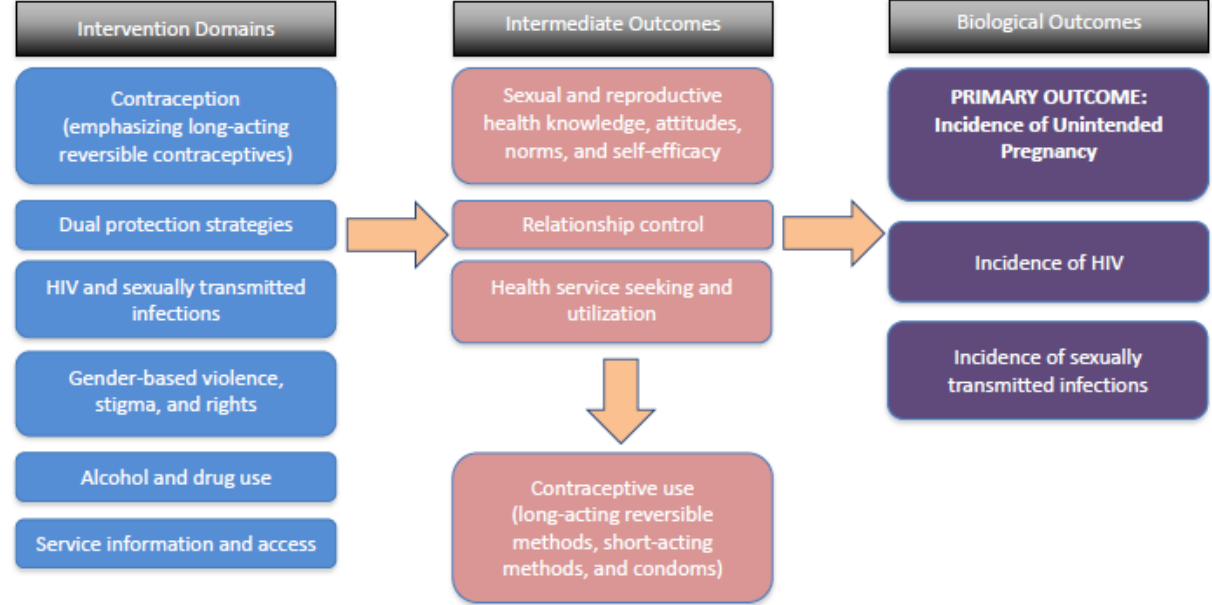
Figure 1. The Women’s Health Intervention using SMS for Preventing Pregnancy program